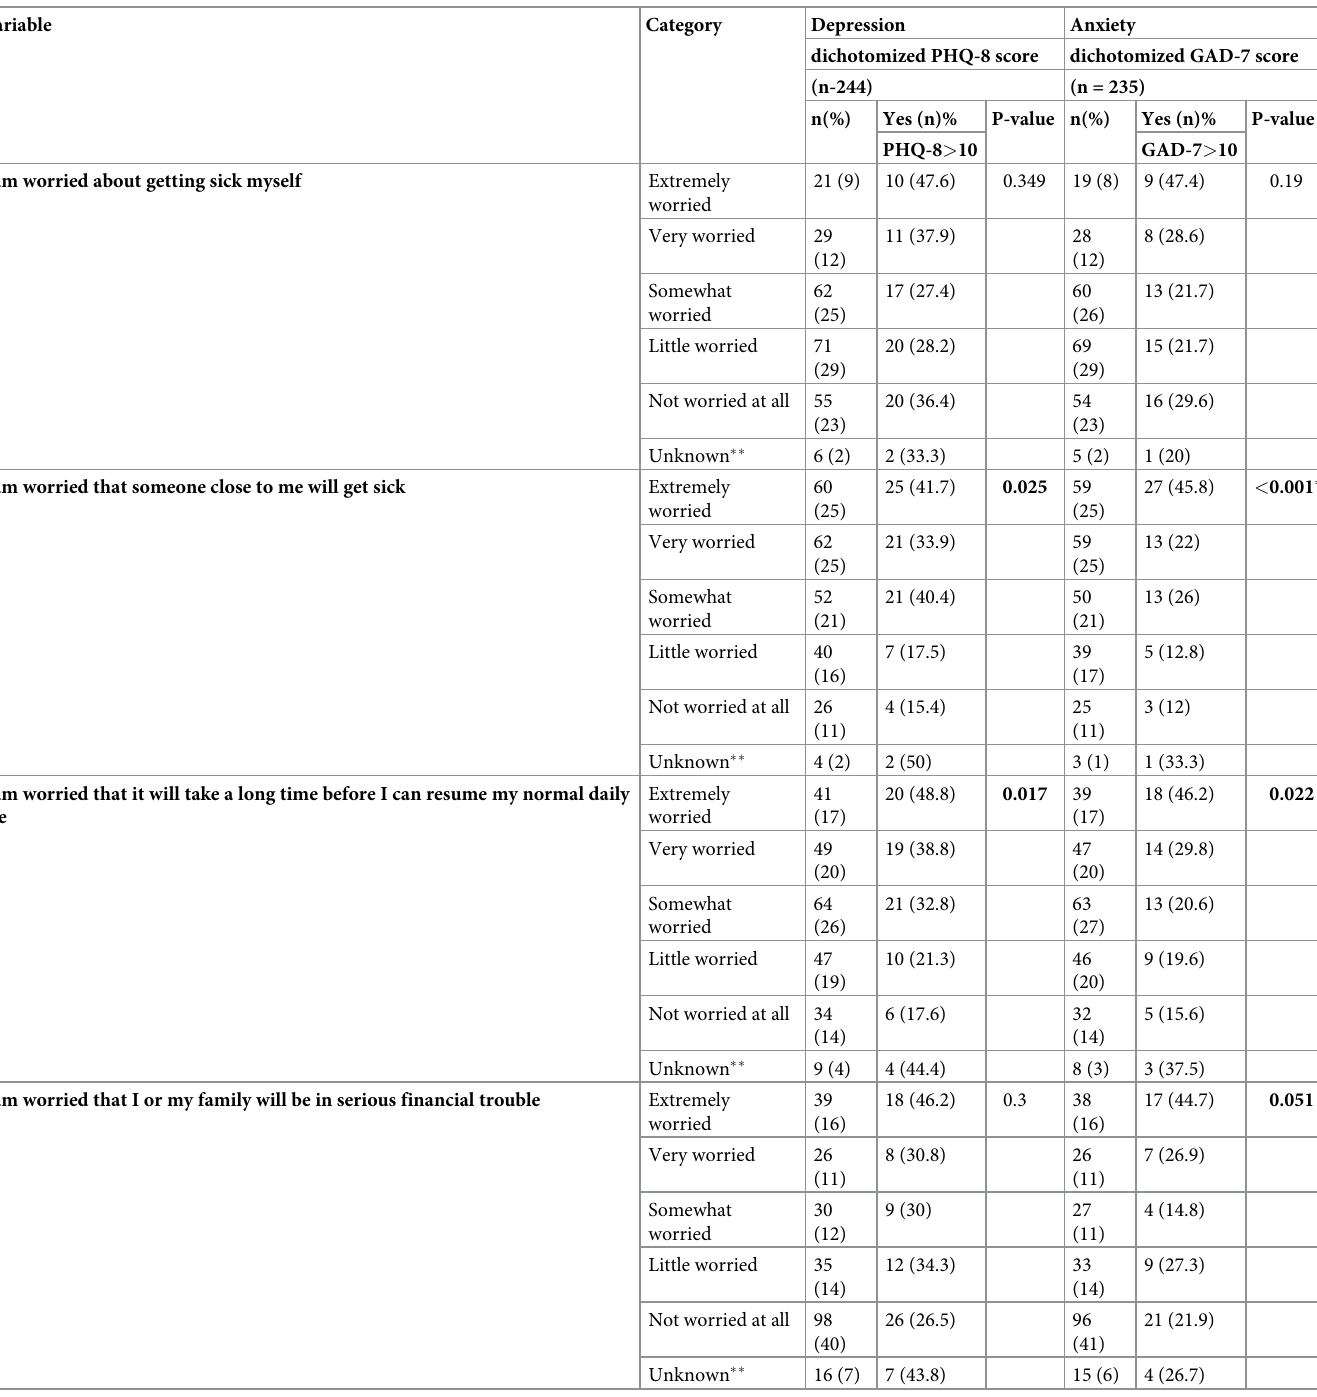
Table 2. Pandemic worries by the dichotomized PHQ-8 score (PHQ-8 > 10) and dichotomized anxiety score (GAD-7 > 10) during the pandemic.